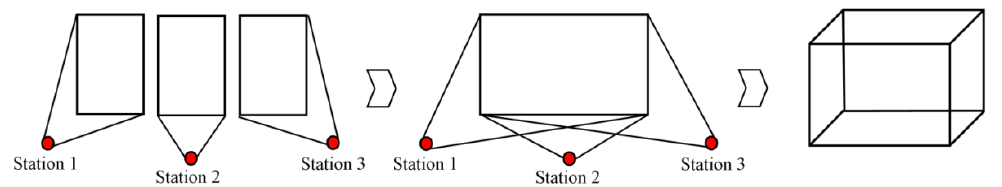
Figure 2. Processing of point clouds resulting from the three-point scan of the Heyman House in order to obtain the final three-dimensional model.